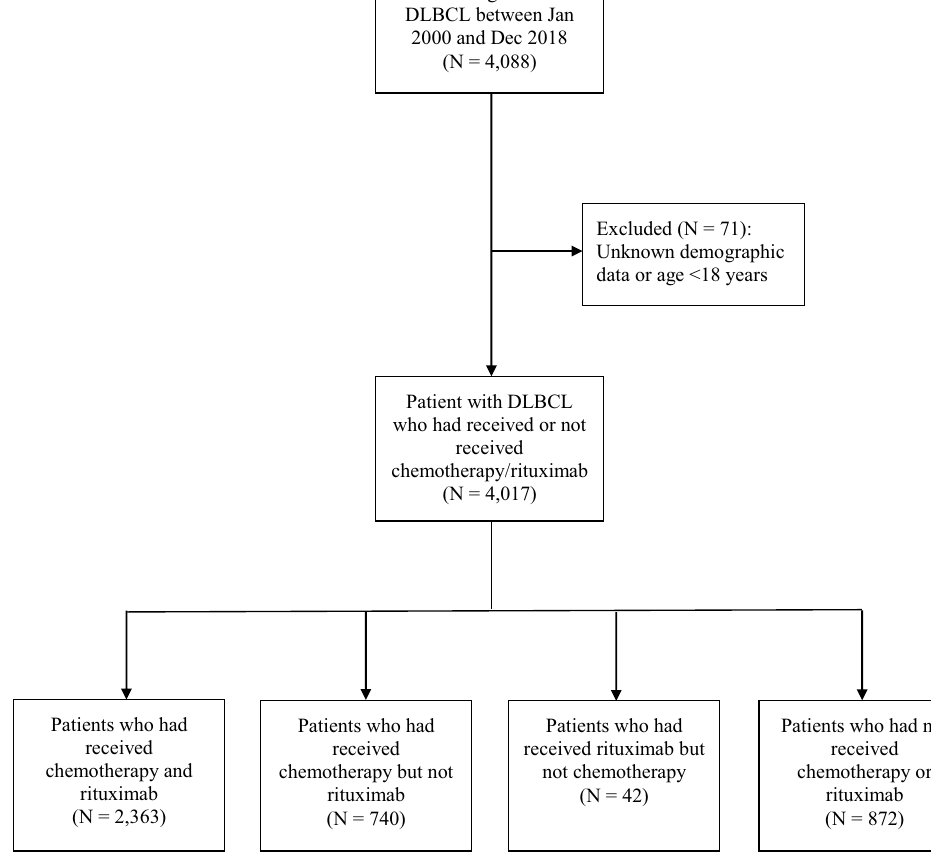
Figure 1. Flowchart outlining the inclusion and exclusion criteria, Hong Kong, 2000–2018 (N = 4017). The light grey bands represent the 95% confidence interval bands. DLBCL, diffuse large B-cell